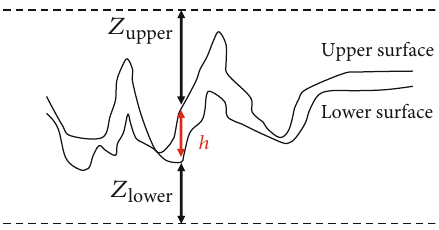
Figure 4: Schematic of z and h . z represents the height of the upper upper surface, z represents the height of the lower surface, lower and h represents the aperture (the gap between the two